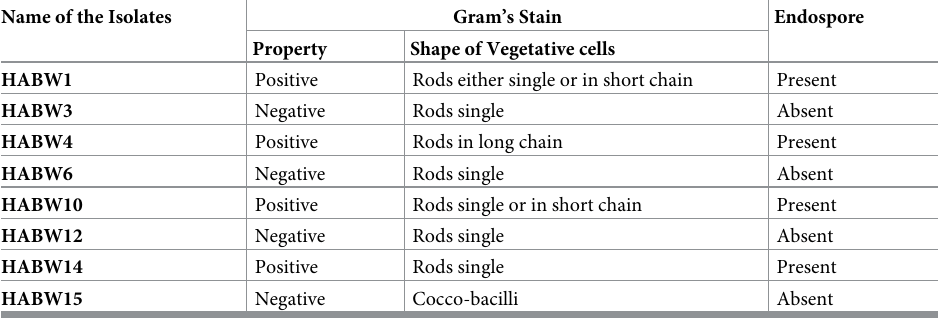
Table 6. Staining properties of common bacterial isolates from breeding habitats of Anopheles subpictus mosquito. Name of the